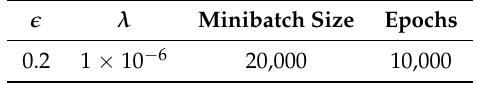
Table 2. Parameters used in the model training framework.